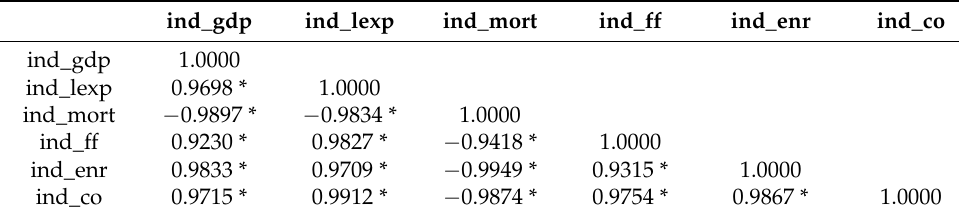
Table 5. Correlation matrix of India.